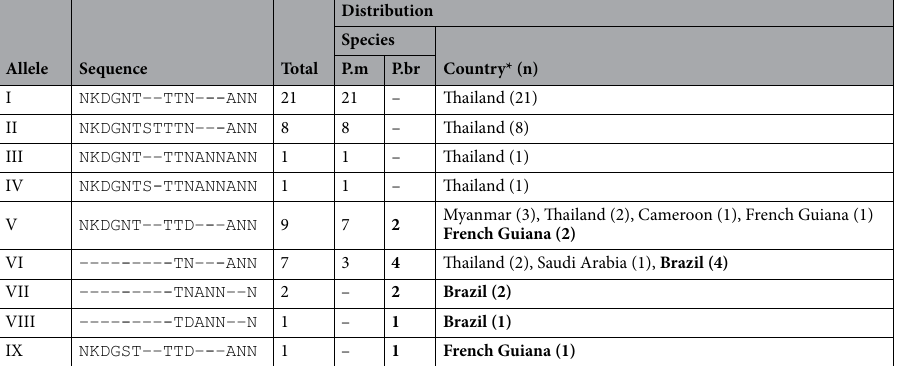
Table 1. Distribution of alleles in block II of PmMSP1 and PbrMSP1 . P.m and P.br denote Plasmodium malariae and P. brasilianum , respectively. Thai isolates and GenBank accession numbers of isolates elsewhere are (I) PM2-PM8, PM10, PM14, PM16-PM19, PM22-PM26 and PM31-PM33; (II) PM9, PM11, PM12, PM21, PM28-PM30 and PM34; (III) PM1, (IV) PM35, (V) PM20, PM27, FJ824669, KX672046-KX672048,